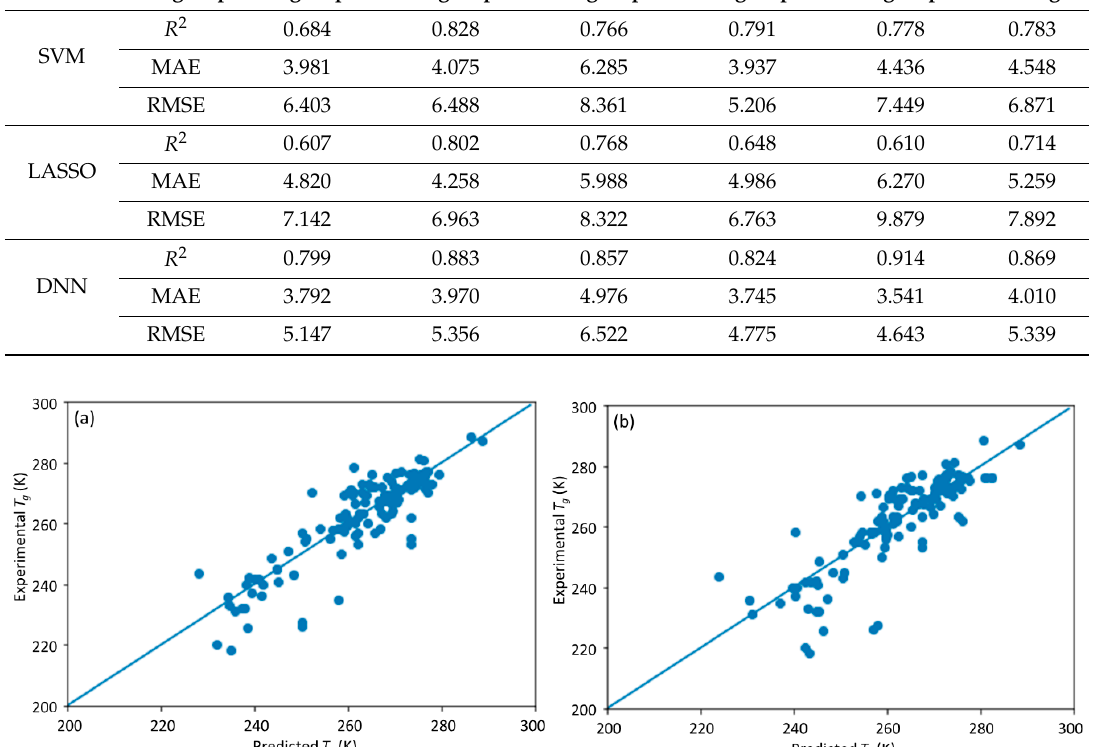
Table 2. Comparison of the results by the support vector machine (SVM), least absolute shrinkage and selection operator (LASSO) model, and DNN model.